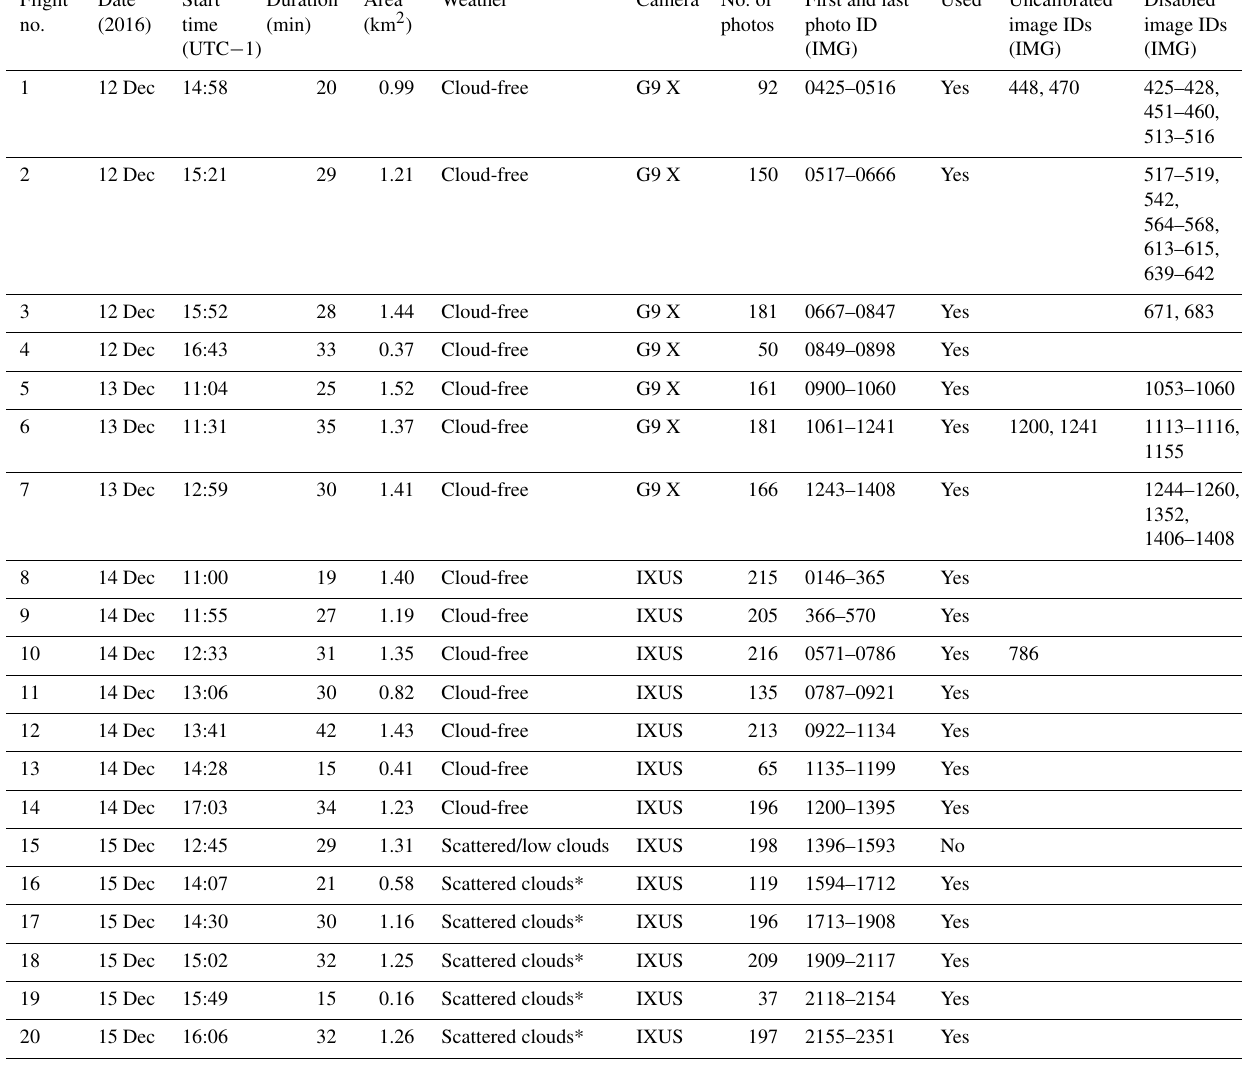
Table 1. Synthesis of flight characteristics and photos excluded from the modelling due to lack of calibration or manually disabled in the pre-processing. Flight